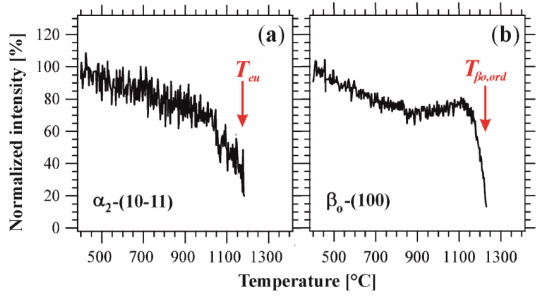
Figure 7. Intensity evolutions of the α 2 -(10-11) ( a ) and β o -(100) ( b ) superstructure peaks during heating The loss of order is indicated through the sharp decrease in intensity. The intensities, which are plotted as a function of temperature, are normalized to the intensity observed at 400 ˝ C and given in %. (Reproduced with permissions from Reference [52]. Copyright © Wiley-VCH Verlag GmbH & Co. KGaA, Weinheim, Germany,